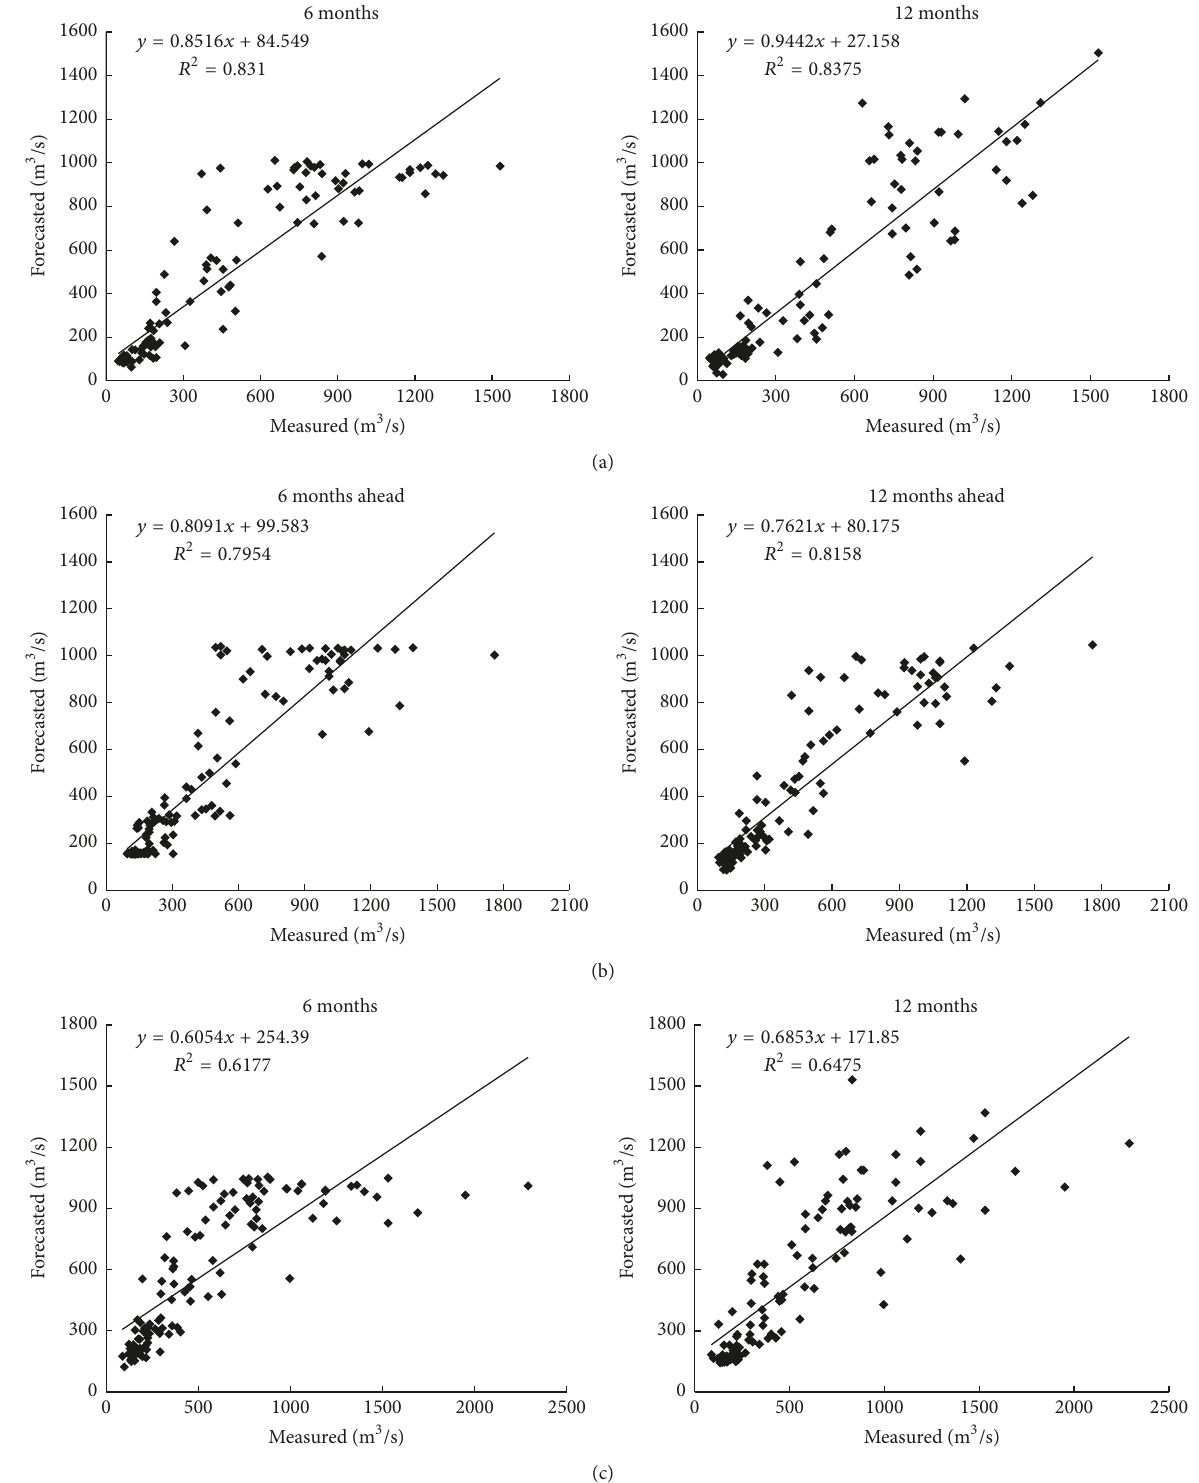
Figure 2: Comparison of the measured runoff values and those forecasted 6 and 12 months ahead by the ANN model for the YARHR (a), the LARHR (b), and the YERHR